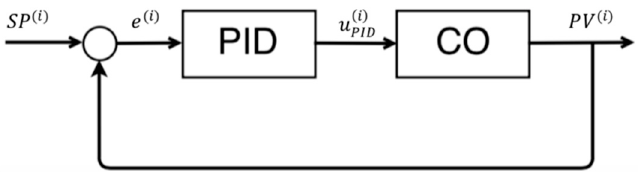
Figure 1. PID (Proportional–Integral–Derivative) control loop structure.